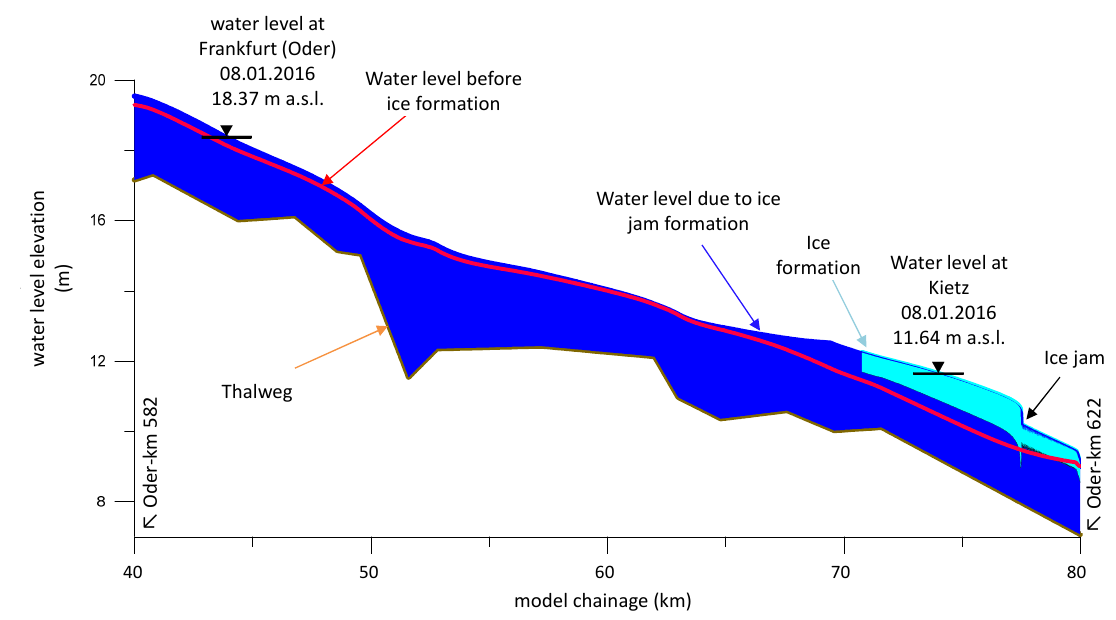
Figure 16. Longitudinal profile of the water levels and ice cover simulated from the ice jam that formed at Kietz in January 2016 (adapted from [18]).